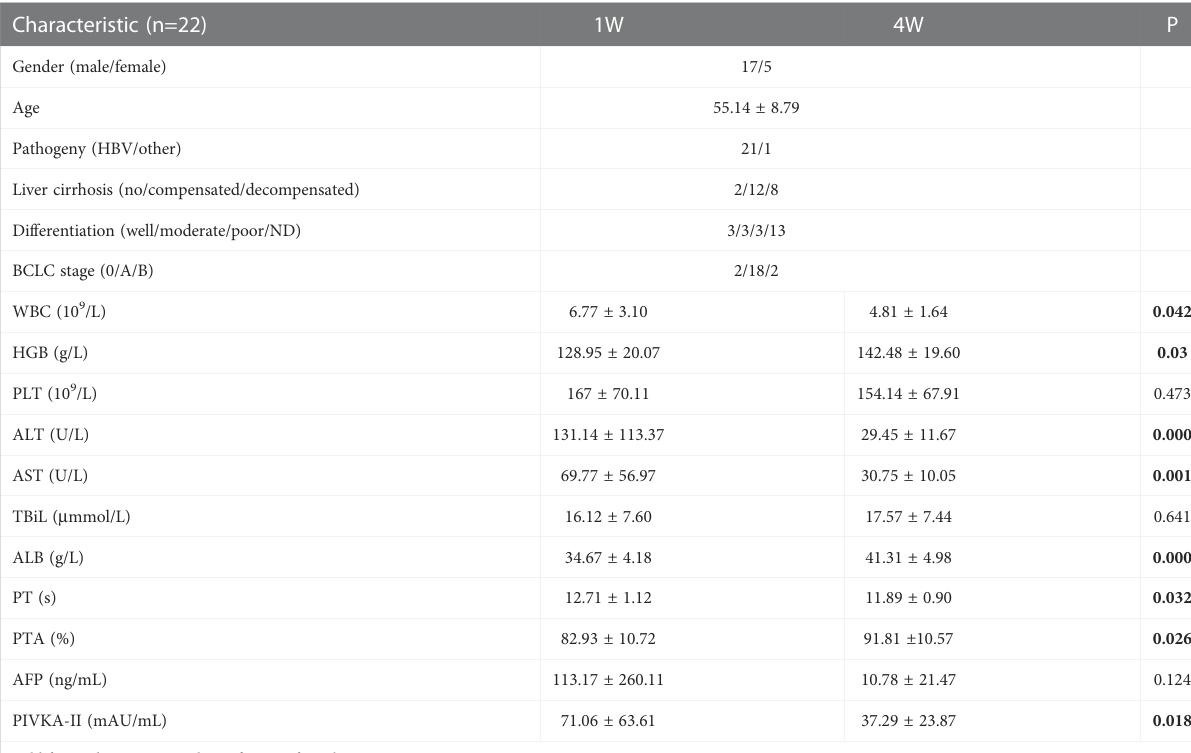
Bold font indicates statistical signi fi cance of P values. TABLE 2C Characteristics of patients in the 1W and 4W cohort.